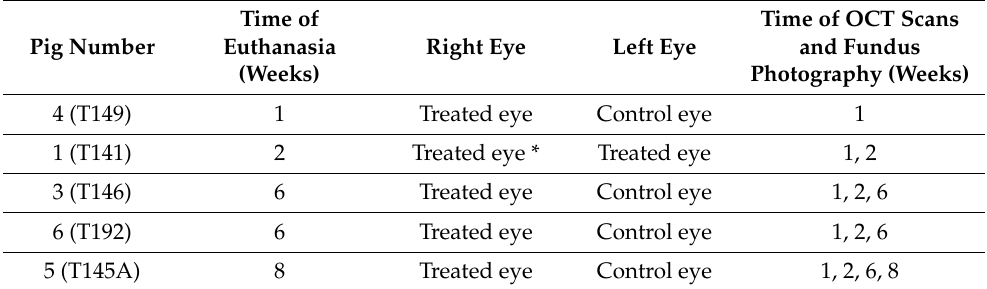
Table 1. Experimental setup and